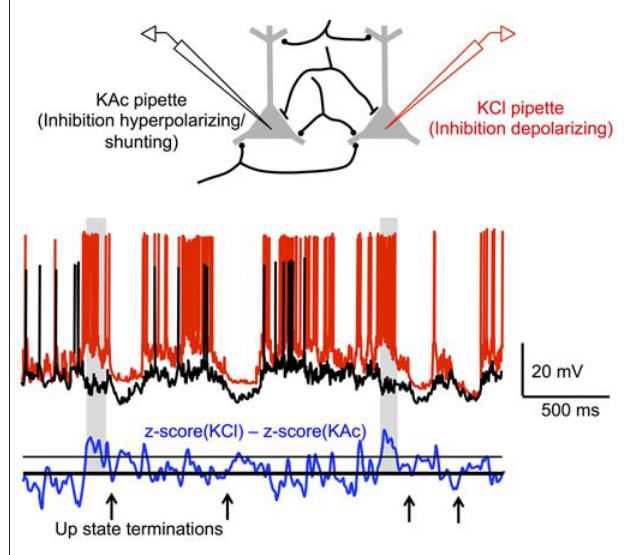
( < 500 µ m) cortical neurons. In recordings with a KAc pipette, inhibition should be hyperpolarizing or shunting, while in recordings with a KCl pipette, inhibition should be depolarizing. Thus, differences between the membrane potential excursions in KAc-KCl dual recordings should predominately reflect inhibition. (Bottom) Dual KAc-KCl recording in sleeping cat cortex. Periods of inhibition (shaded regions) occur above a pre-determined threshold primarily before Up state termination. Adapted by permission from the American Physiological Society: Journal of Neurophysiology (Lemieux et al., 2015), ©